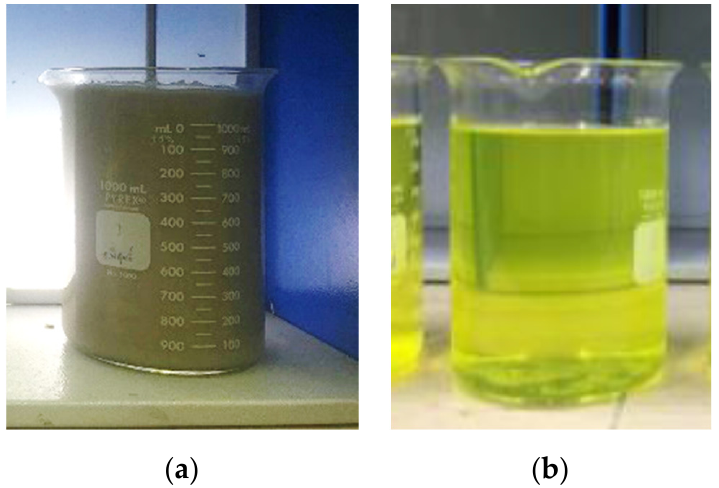
Figure 2. Image of synthetic wastewater: ( a ) turbidity using bentonite and ( b ) color using dye. Table 1. Characteristics of synthetic wastewater used in the present work.